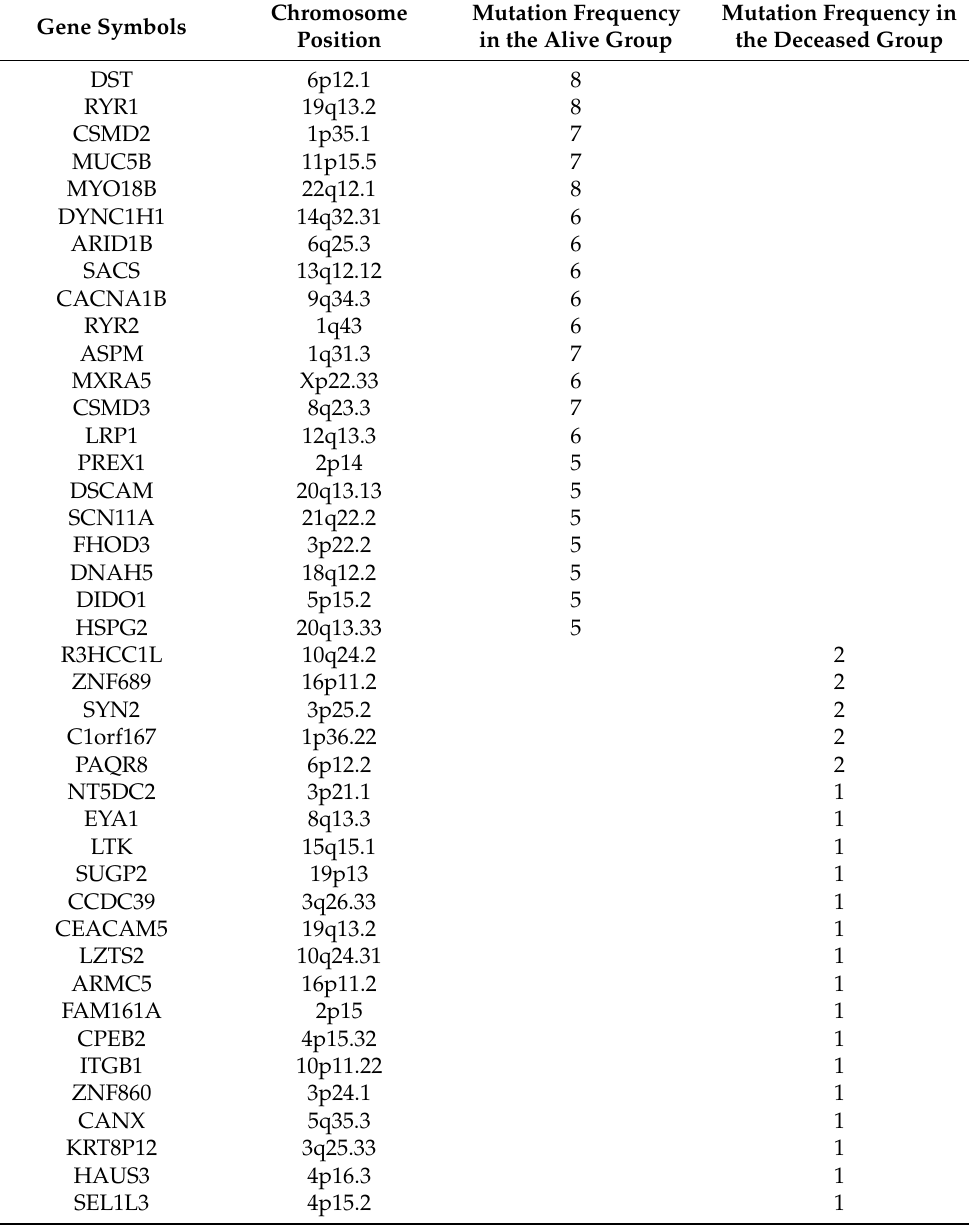
Table 2. Top highly differentially mutated genes transcriptionally associated with TNBC in either alive or